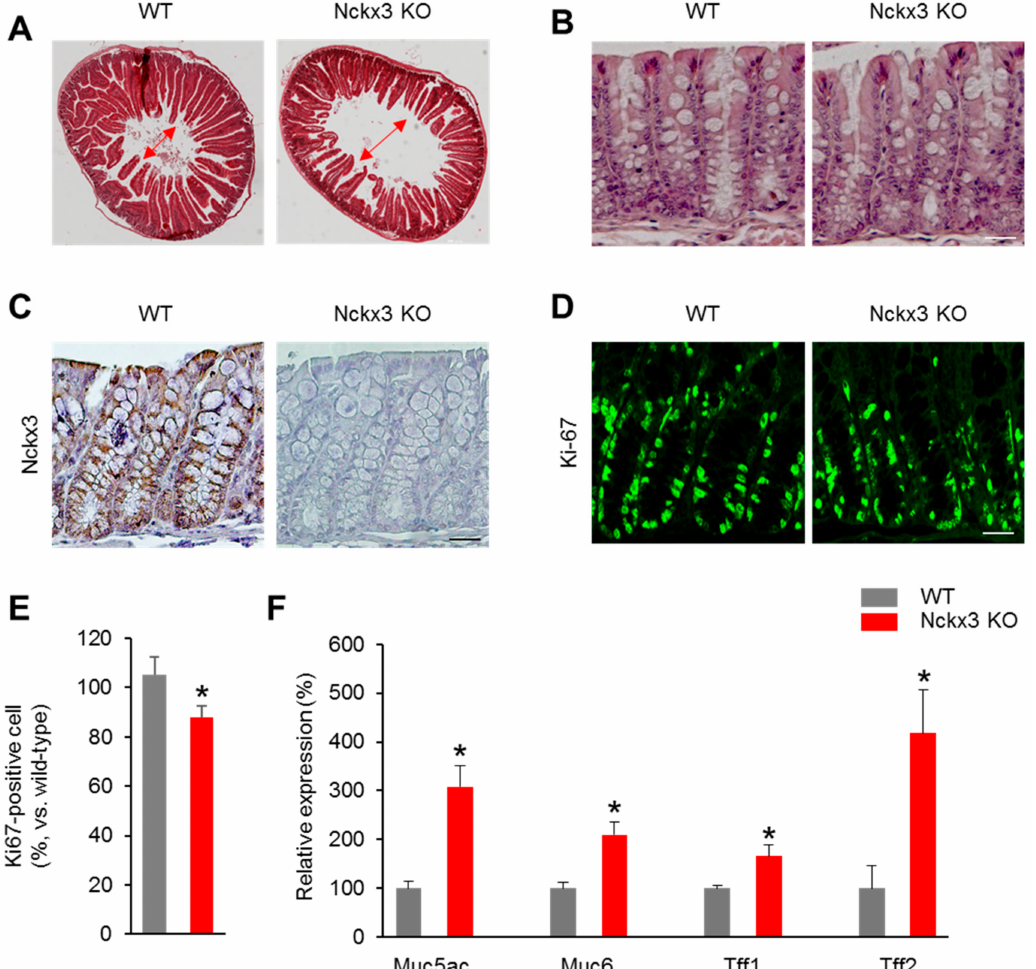
Figure 3. Loss of Nckx3 impairs the morphology in the duodenum and cell proliferation in the colon. Hematoxylin and eosin (H&E)-stained sections of duodenum and middle distal colon tissue collected from WT and Nckx3 KO mice at 6-week-aged (n = 10 per genotype): ( A ) a markable decrease in the length of crypt in the duodenum of Nckx3 KO mice compared to the WT mice. Original magnification: 4 × . However, there was no significant in the morphology of crypt morphology between WT and Nckx3 KO mice ( B ). Original magnification: 10 × ; ( C ) immunohistochemistry analysis of Nckx3 expression in colonic tissues of WT and Nckx3 KO mice—original magnification: 10 × ; ( D ) immunofluorescence detection of Ki67 on colon sections prepared from WT and Nckx3 KO mice—original magnification: 10 × ; ( E ) quantification of ( D ). The number of Ki67 + cells was decreased in the Nckx3 KO group compared to WT group; ( F ) Nckx3 KO groups showed an increase in the mRNA level of proliferation-regulatory genes including Muc5a , Muc6 , Tff1 and Tff2 in the colon compared to the WT group (n = 10 per genotype). Data represent the mean ± SEM. Statistical significance was determined by two-way ANOVA, * p < 0.05 WT vs. Nckx3